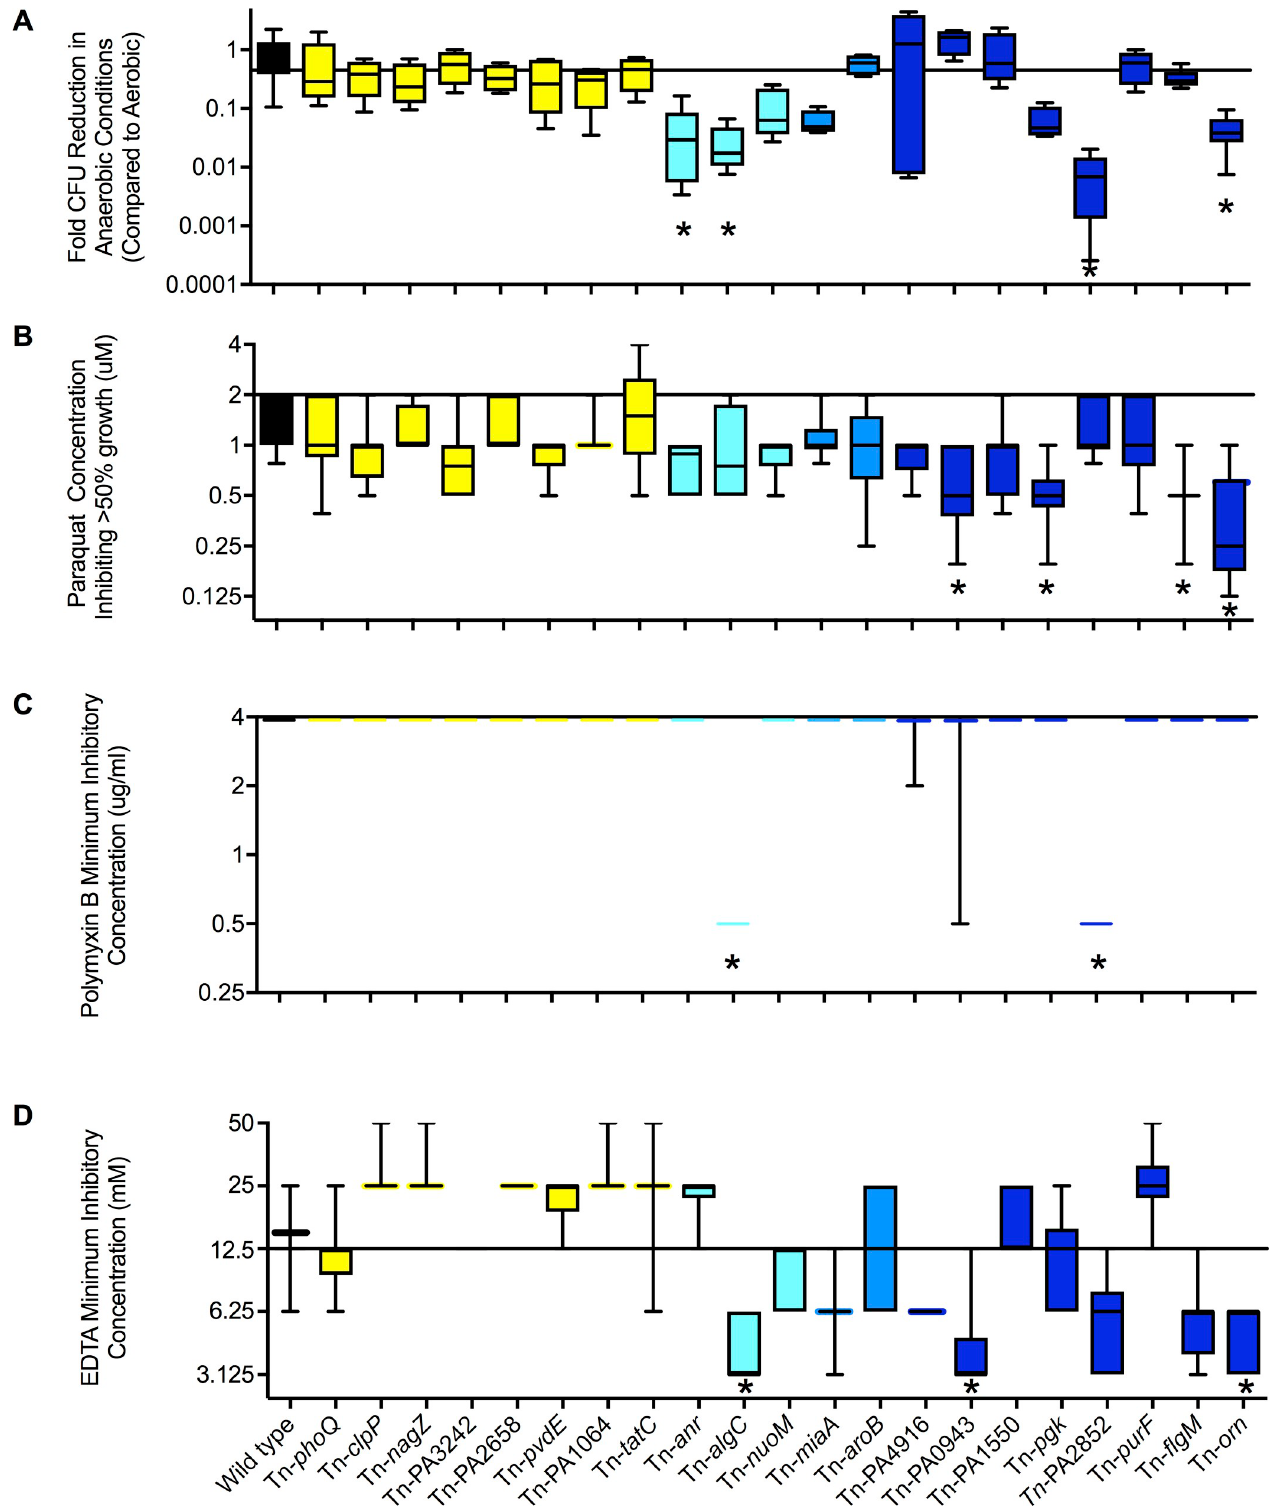
Fig 5. In vitro stress sensitivity of mutants with high and low wound fitness. Mutants with high (yellow bars) and low (blue bars, darker blue indicates more severe defects) wound fitness were tested for anaerobic growth capacity ( A ); and sensitivity to paraquat ( B ), polymixin B ( C ), and EDTA ( D ). Data is shown as box plots indicating the median, and 25 th and 75 th percentiles of at least three experiments (performed in duplicate with error bars showing the range. � indicates p < 0.05 compared to wild type by non-parametric ANOVA (Kruskal-Wallis and Dunnet’s test).